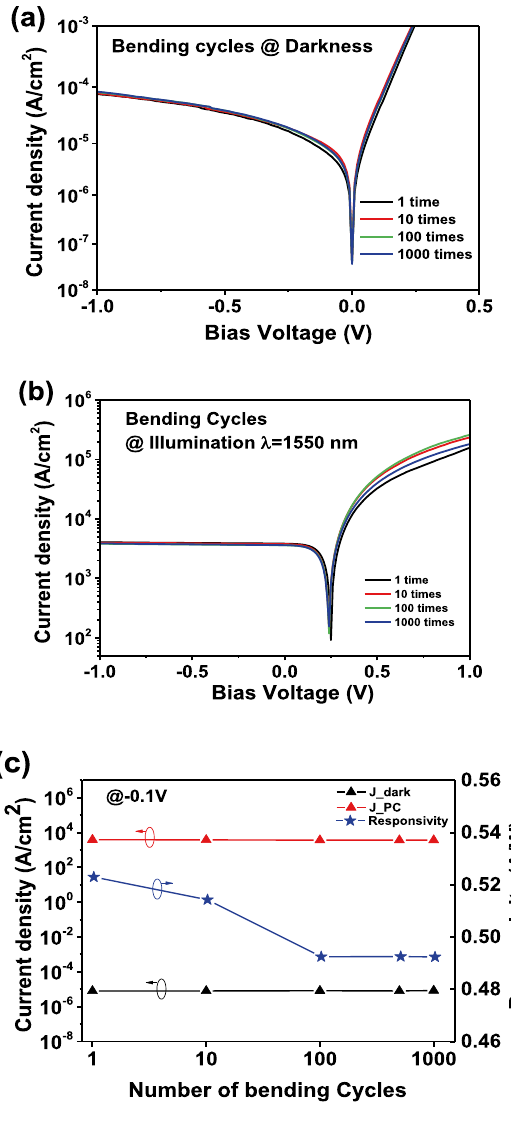
Figure 8. Devices characterization after multiple bending down cycle of 1, 10, 100, 1000 times (a radius of R = 15 mm): ( a ) Dark density of the devices; ( b ) Photocurrent density of the devices; ( c ) Left: Dark and photocurrent (PC) density of the devices at − 0.1 V; Right: Responsivity of the device at 1550 nm (P = 230 μW) at − 0.1